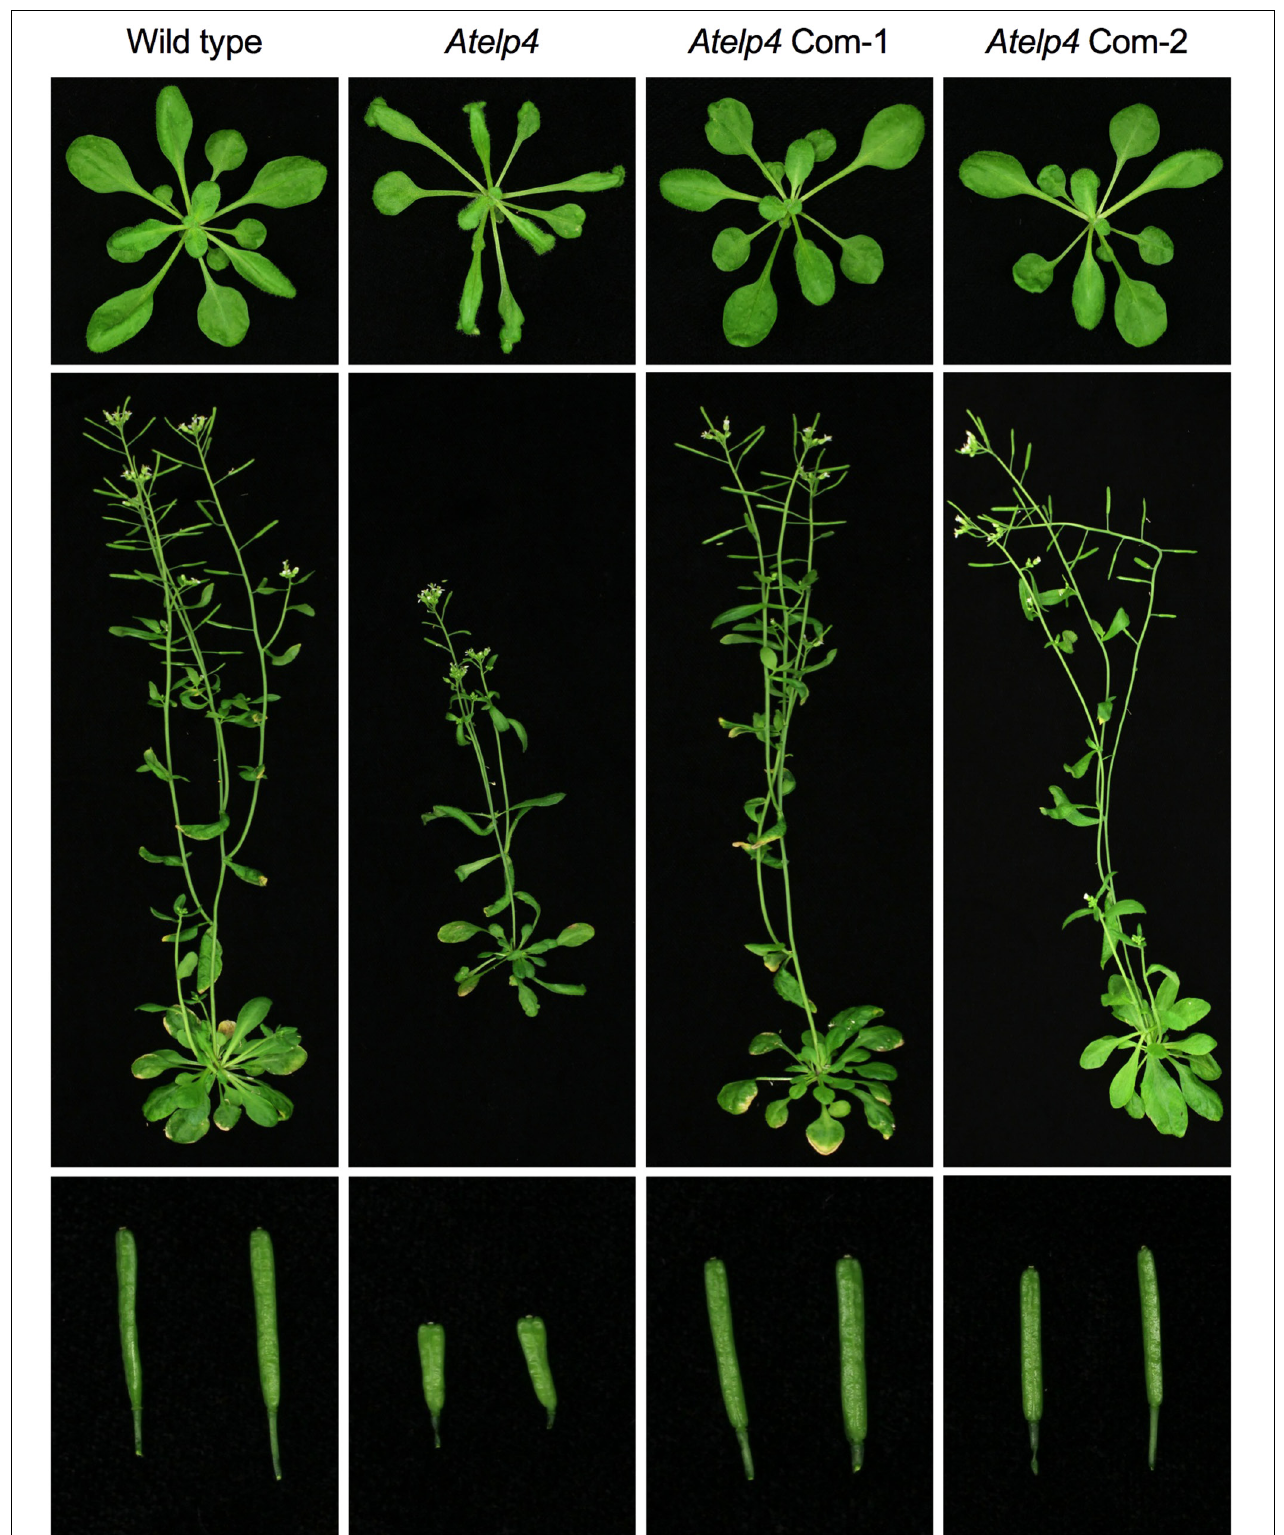
FIGURE 6 | Complementation of the Arabidopsis Atelp4 mutant by SlELP4 . Morphological phenotypes of Arabidopsis wild type, Atelp4 , and two independent complementation lines ( 35S::SlELP4 Atelp4 ): Atelp4 Com-1 and Atelp4 Com-2. (Top) 3-weak-old plants; (Middle) 6-week-old plants; (Bottom) siliques.